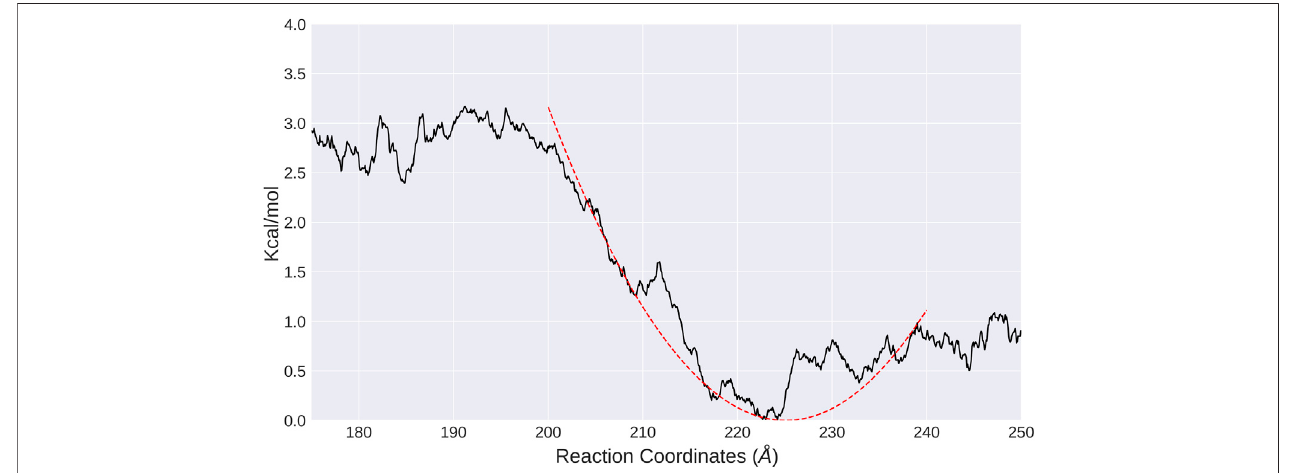
FIGURE3 | PMF calculated from umbrella sampling inthe LN system along thedistancebetweentwo nucleosomes(black solidline). The fi tted harmonic potential function is shown as red dotted line.